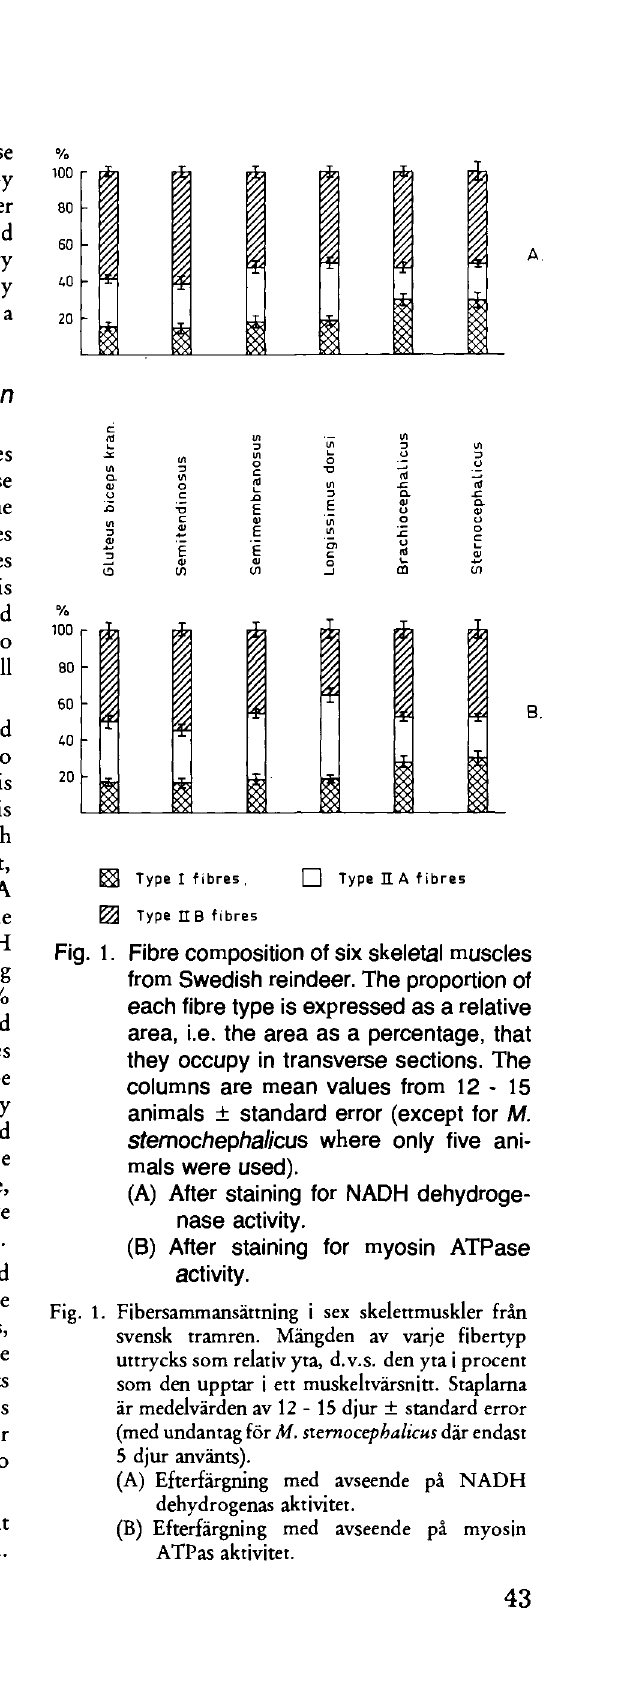
Fig. 1. Fibre composition of six skeletal muscles from Swedish reindeer. The proportion of each fibre type is expressed as a relative area, i.e. the area as a percentage, that they occupy in transverse sections. The columns are mean values from 12-15 animals ± standard error (except for M. sternochephalicus where only five ani mals were